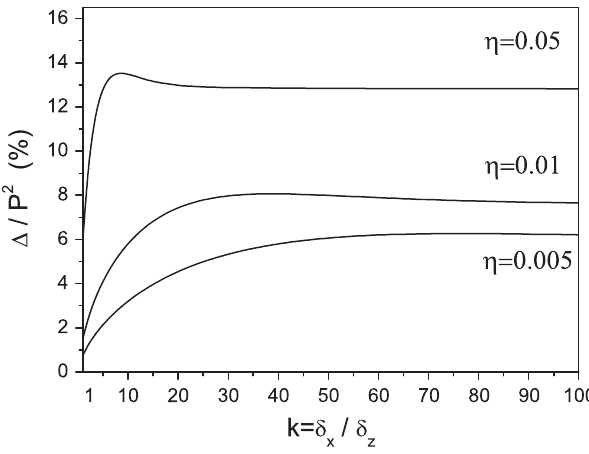
FIG. 2. Dependence of maximal jump (cid:1) =P 2 on k ¼ (cid:1)